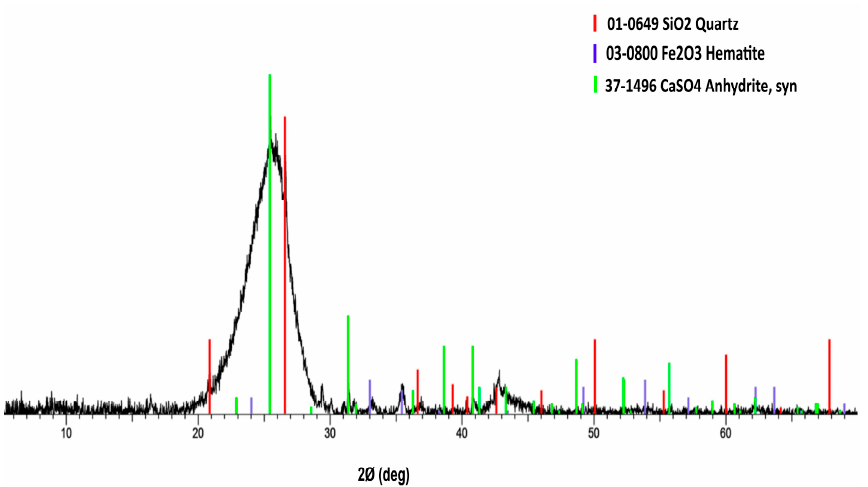
Figure 1. Coke dust waste powder.